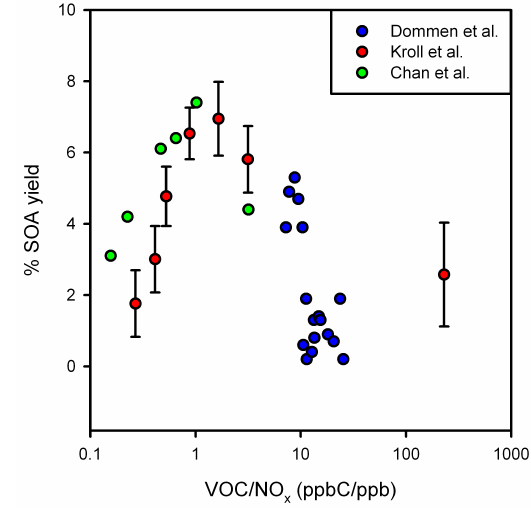
Fig.1. PercentageyieldofSOAvsVOC/NO x ratio, forexperimentsperformedbyDommenetal.(2006), Fig. 1. Percentage yield of SOA vs VOC/NO x ratio, for experiments Kroll et al. (2006), and Chan et al. (2010a). The highest yields are observed at VOC/NO x ratios between performed by Dommen et al. (2006), Kroll et al. (2006), and Chan 1 and 10. All data are normalized to density = 1.4 g cm − 3 . Because the NO x concentration for the data et al. (2010a). The highest yields are observed at VOC/NO x ratios point at the highest VOC/NO x ratio is ¡1ppb, this data point represents the lower bound for the VOC/NO x between 1 and 10. All data are normalized to density=1.4gcm − 3 . ratios. Because the NO x concentration for the data point at the highest VOC/NO x ratio is < 1ppb, this data point represents the lower bound for the VOC/NO x